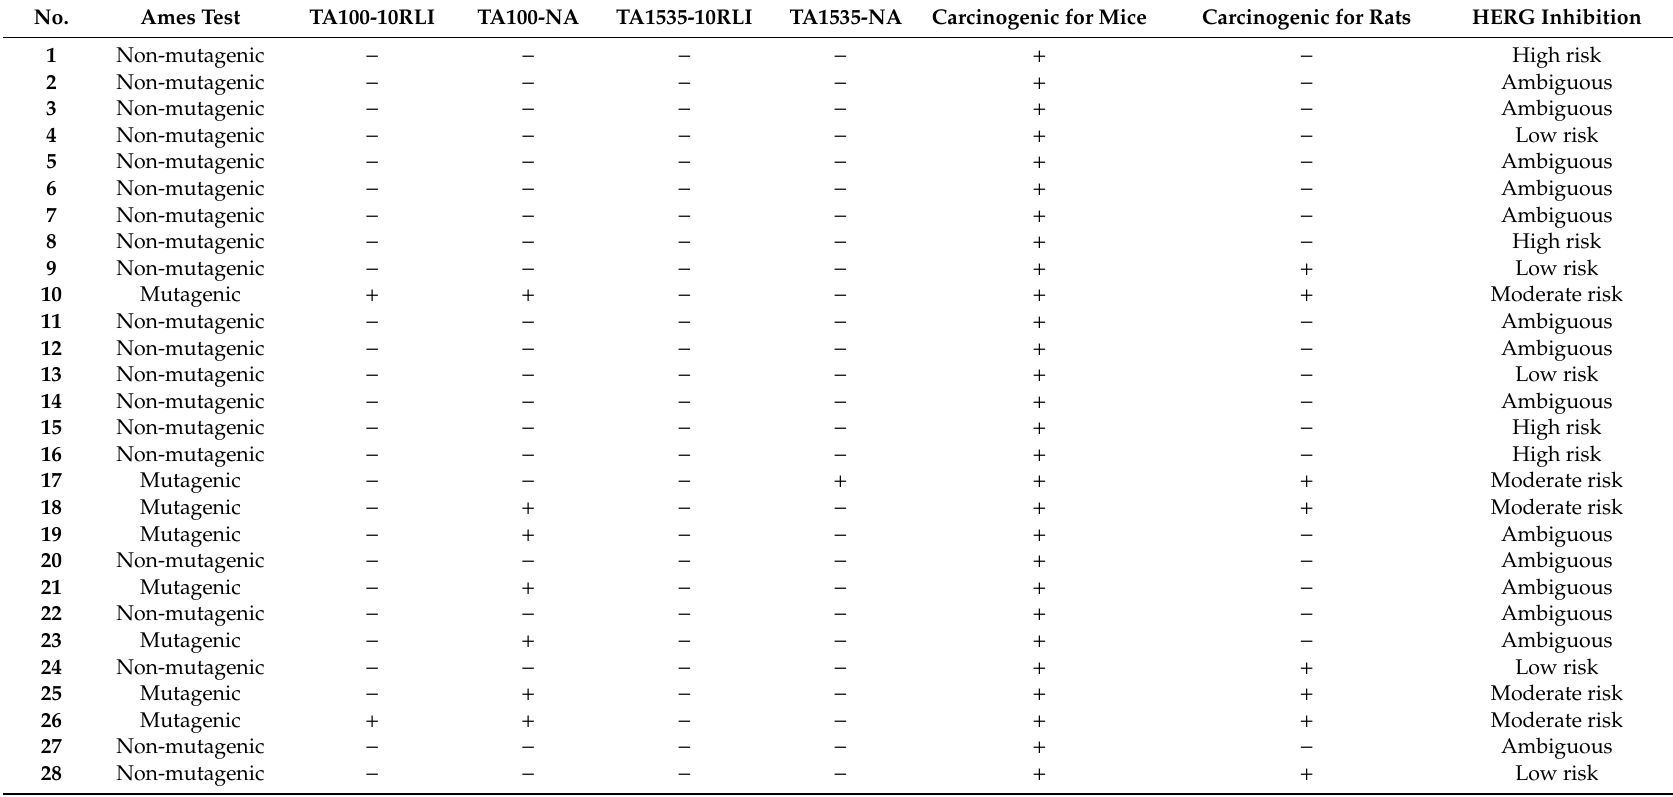
Table 3. Toxicity profile of the LC–HRESIMS dereplication metabolites of Premna odorata leaves crude extract using in silico predicts absorption, distribution, metabolism, excretion, and toxicity (PreADMET)